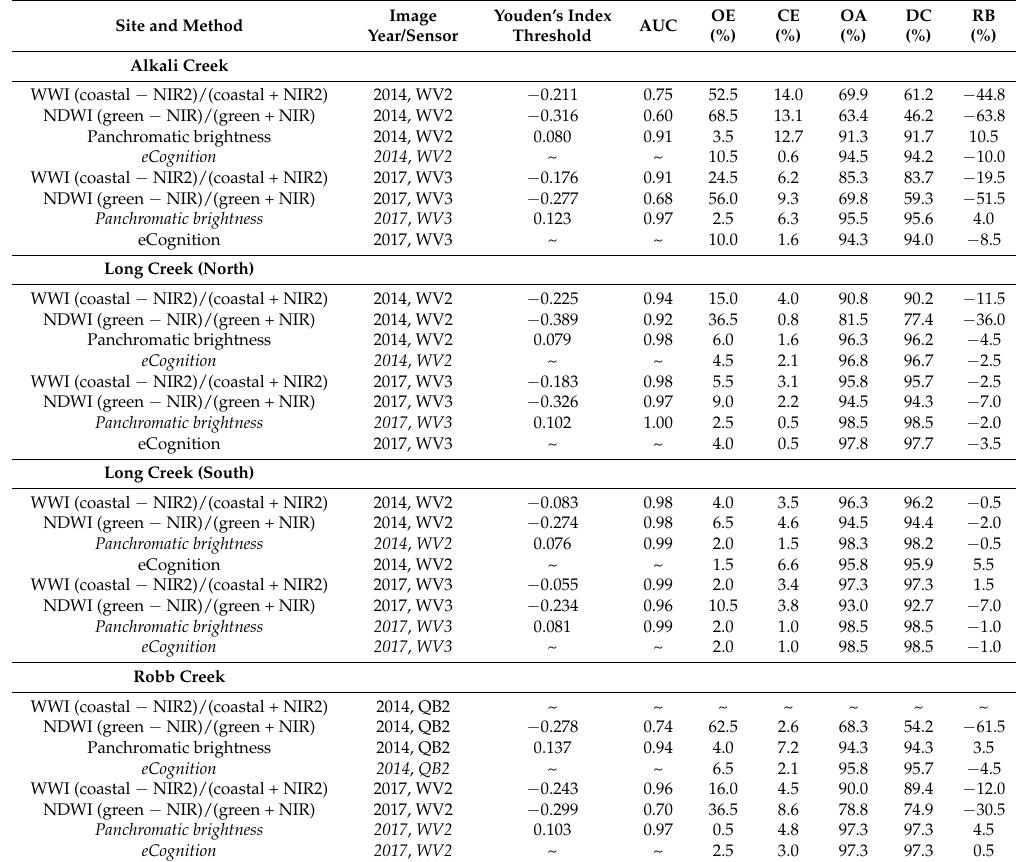
Table 3. A comparison of the accuracy of methods to map stream extent across sites and image dates. Errors are presented for the accuracy of mapping stream surface area extent. All methods listed are pixel-based except for eCognition which is object-based. WWI: Worldview Water Index; NDWI: Normalized Difference Water Index; WV2: Worldview-2; WV3: Worldview-2; QB2: QuickBird-2; OE: omission error; CE: commission error; OA: overall accuracy; DC: Dice coefficient; RB: relative bias; AUC: area under curve; NIR: